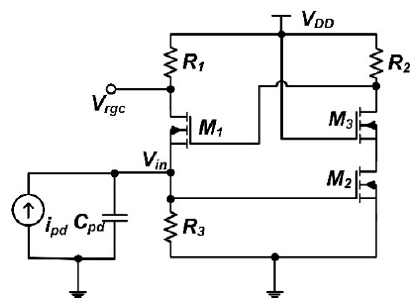
Figure 1. Standard RGC TIA design with additional cascode transistor (cid:1839) (cid:2871) [3–7].